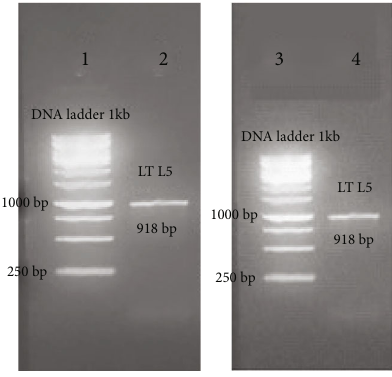
Figure 2: Ampli fi cation products of L. tropica ribosomal protein L5 on 1% agarose gel electrophoresis stained with ethidium bromide. Lanes 1 and 3: DNA ladder 1kb. Lane 2: ribosomal protein L5- DNA ampli fi cation product approximately 918bp. Lane 4: